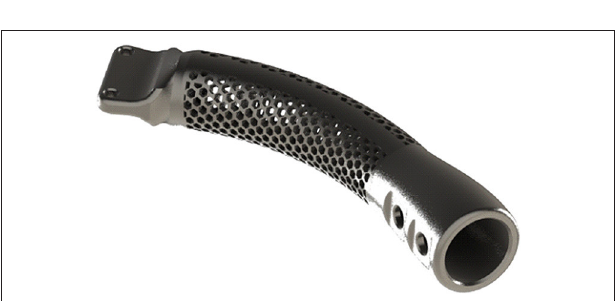
FIGURE 3 | Titanium design of the lateral half of the clavicle. The size of the prosthesis corresponded to that of the lost portion of the clavicle, and the prosthesis had a porous structure to reduce the